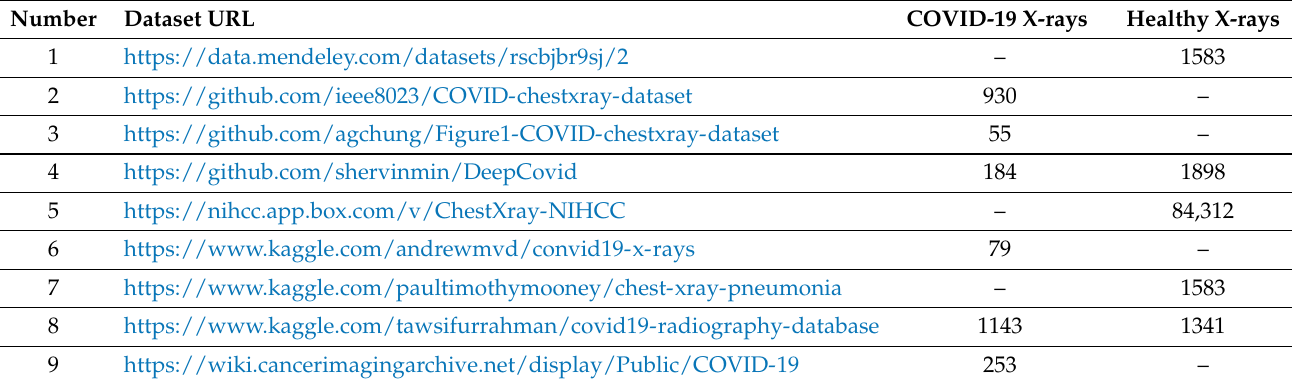
Table 7. Available datasets and number of